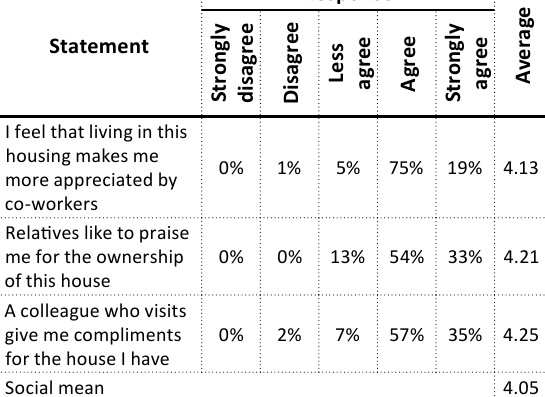
Table 11. Product construct descriptive statistics